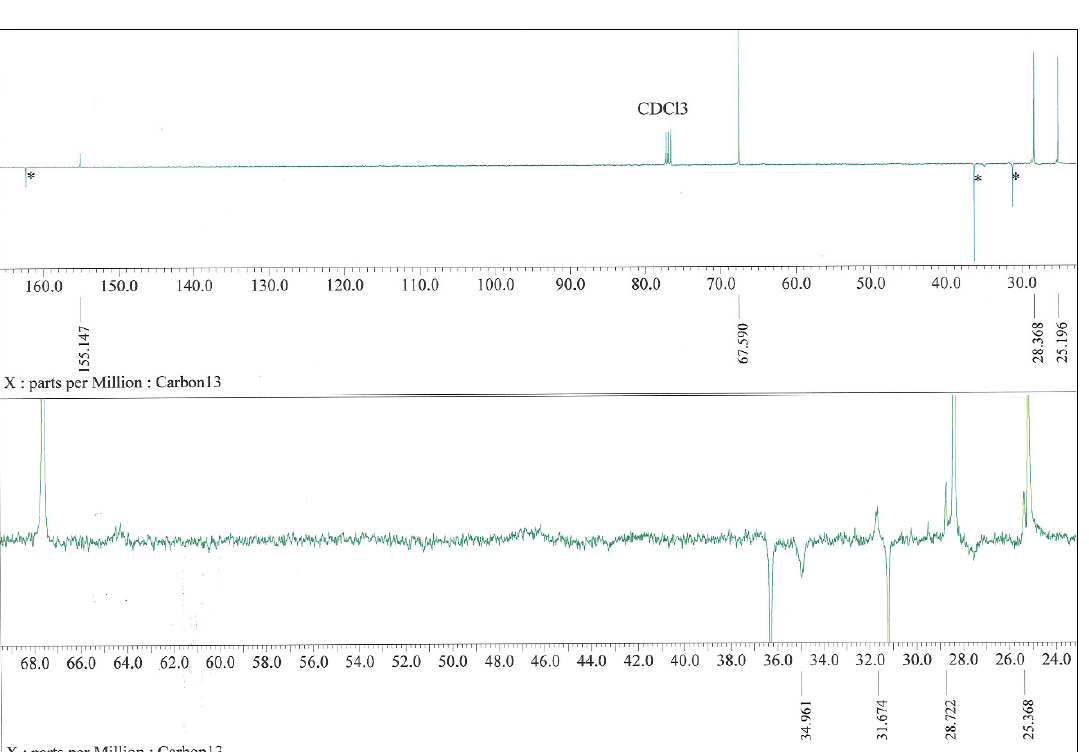
Figure 5. 13 C APT NMR spectrum of Larithane in CDCl 3 . The upward peaks belong to the -CH 2 - and C carbons, while the downward peaks belong to the -CH and -CH 3 carbons. The DMF signals are marked with an asterisk (*).